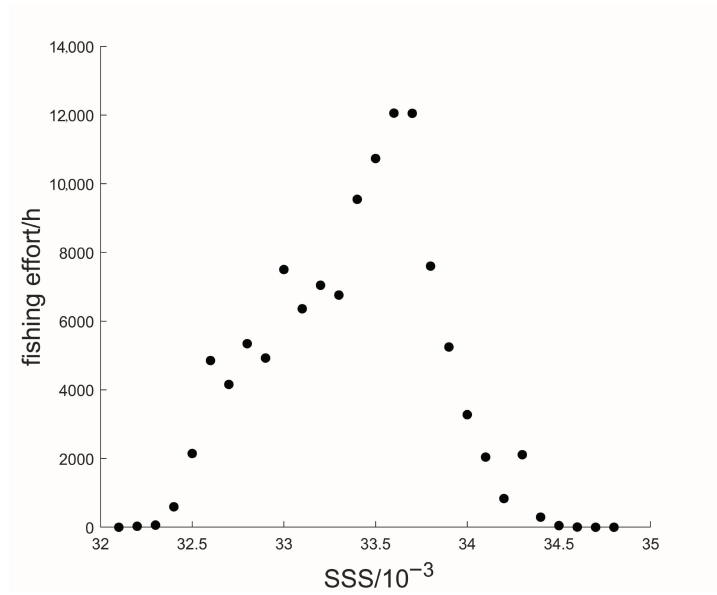
Figure 8. Scatter plot for the relationship between fishing effort and